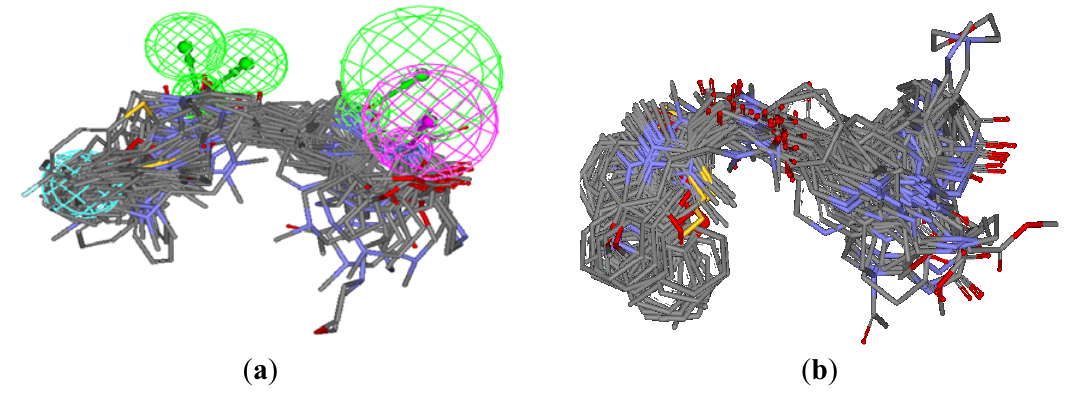
Figure 3. ( a ) Alignment of the training and test set molecules based on the pharmacophore model; ( b ) docking-based alignment of the training and test set